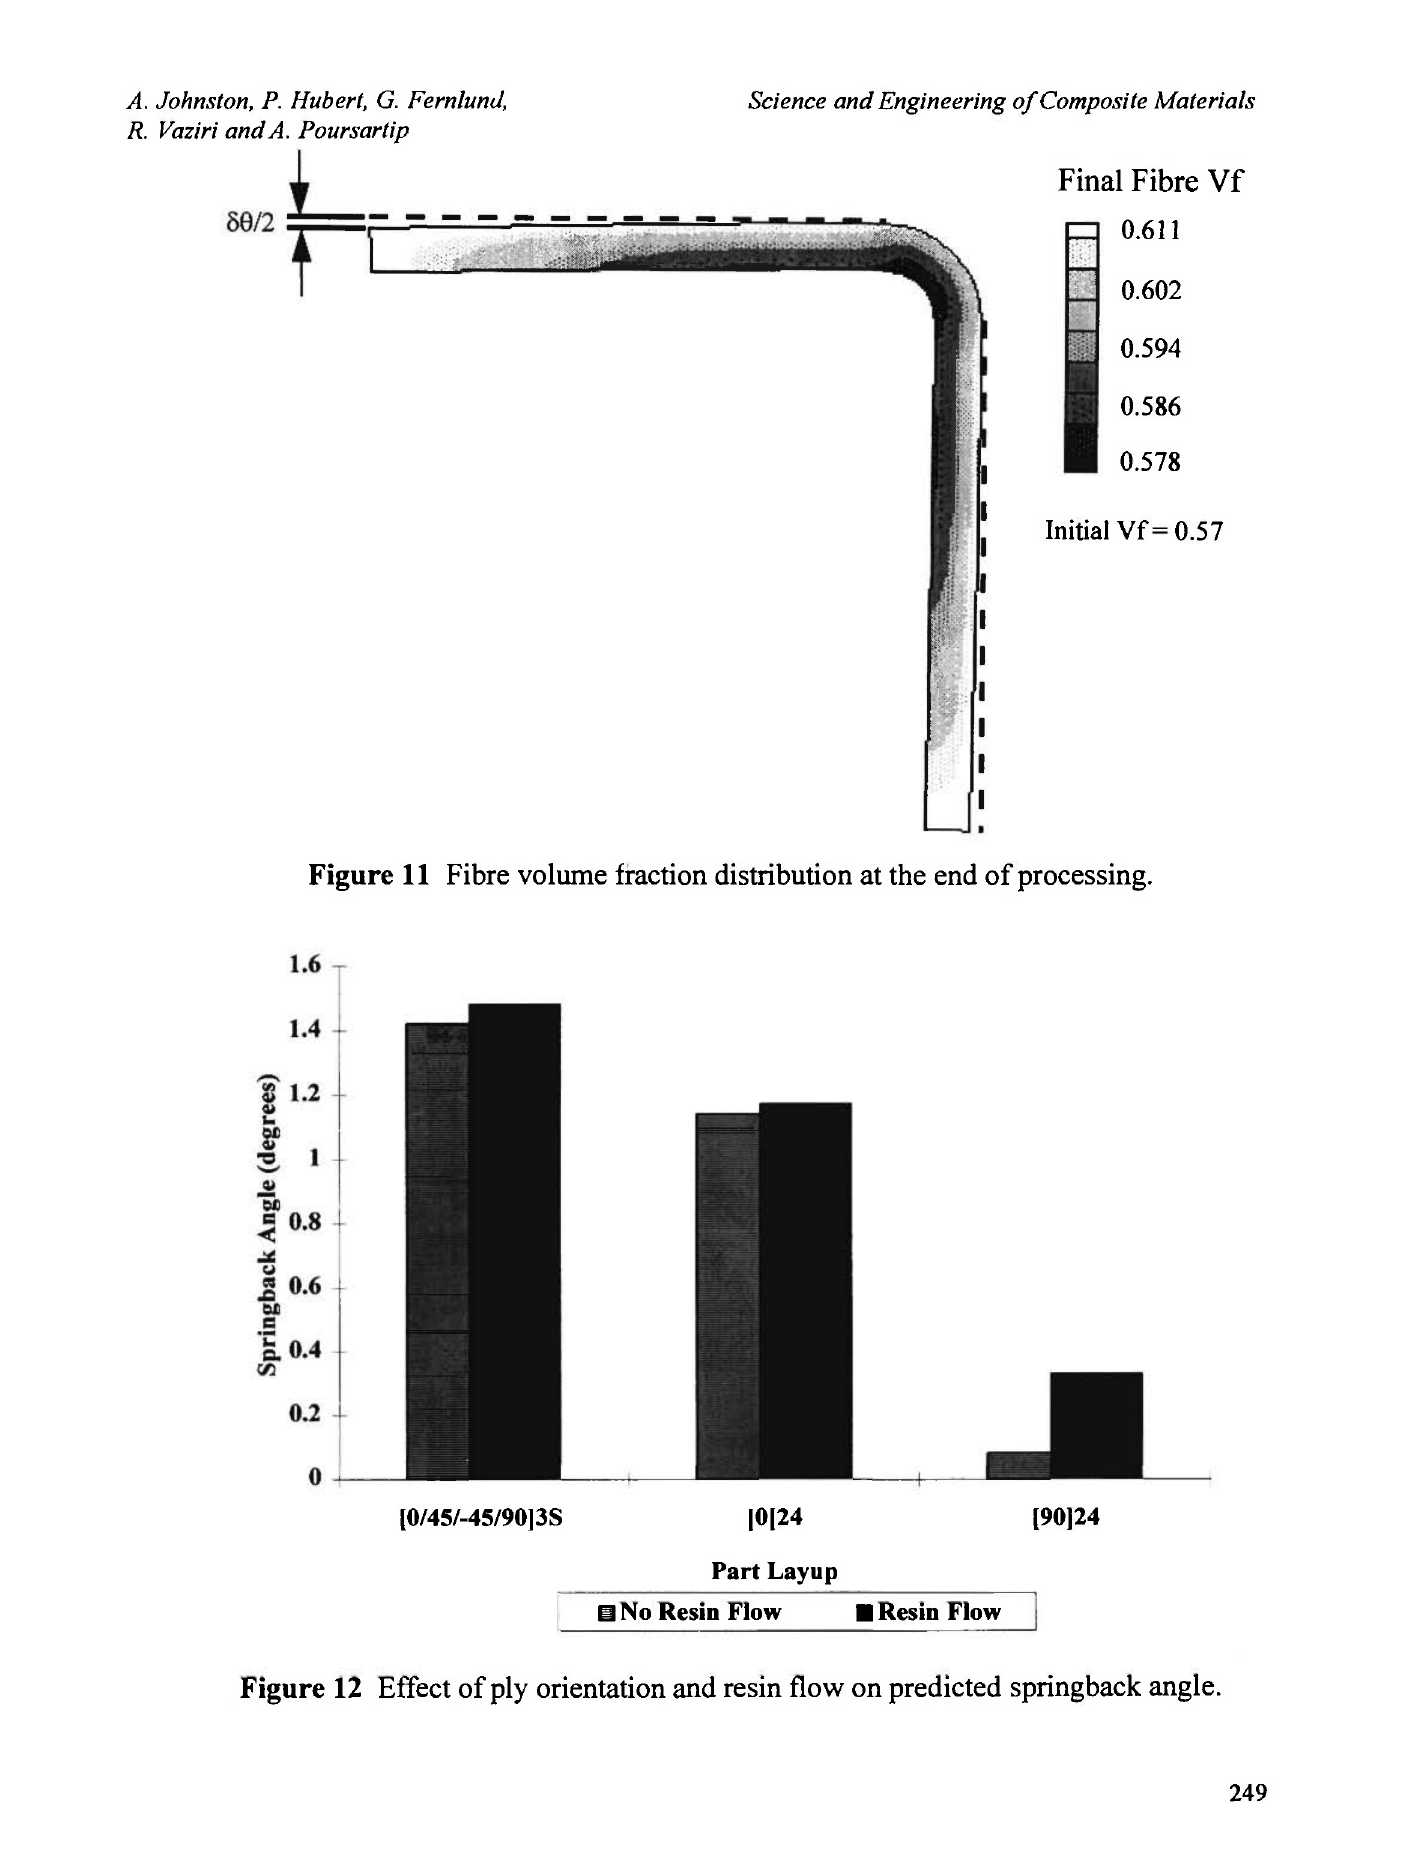
Figure 12 Effect of ply orientation and resin flow on predicted springback